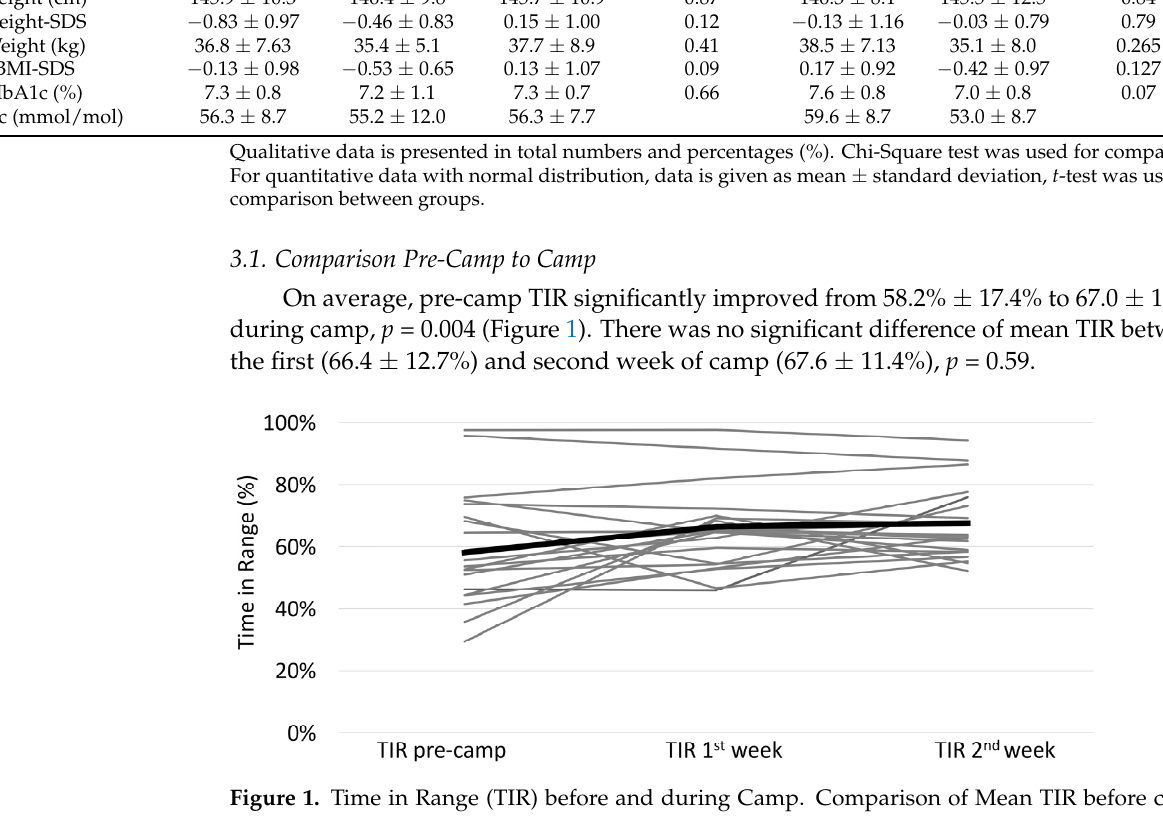
Table 2. Glycemic Control before and during Camp.